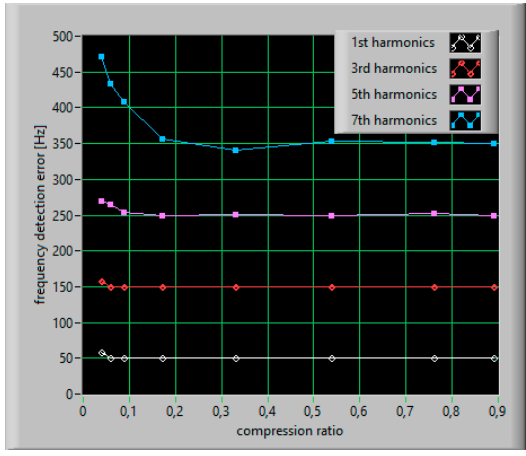
Figure 14. The graphical user interface of Lasso software. Figure 13. The accuracy of frequency detection versus compression ratio. Figure 13. The accuracy of frequency detection versus compression